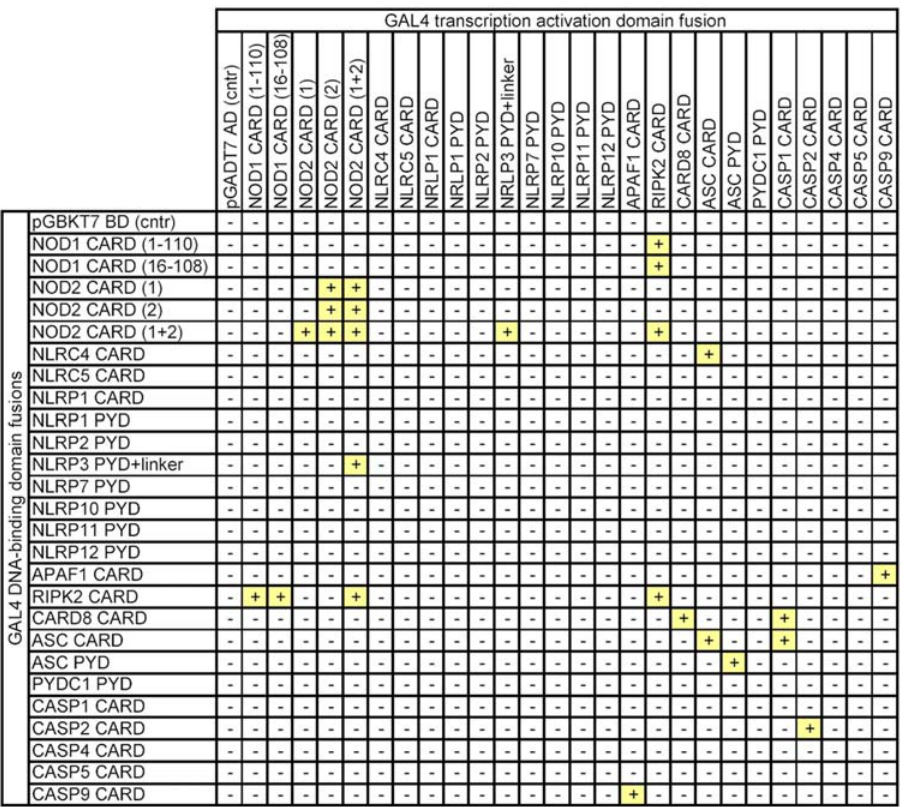
Figure 1. The interaction matrix. In an ‘‘each against all’’ approach an overall number of 676 (26 6 26) effector domain combinations were analyzed. A ‘‘ + ’’ indicates an interaction between a particular pair, whereas ‘‘ 2 ’’ symbolizes no interaction. In total, the approach yielded 25 distinct associations, which actually corresponded to 7 unique pairs of interacting proteins, as well as 5 homodimerizations.